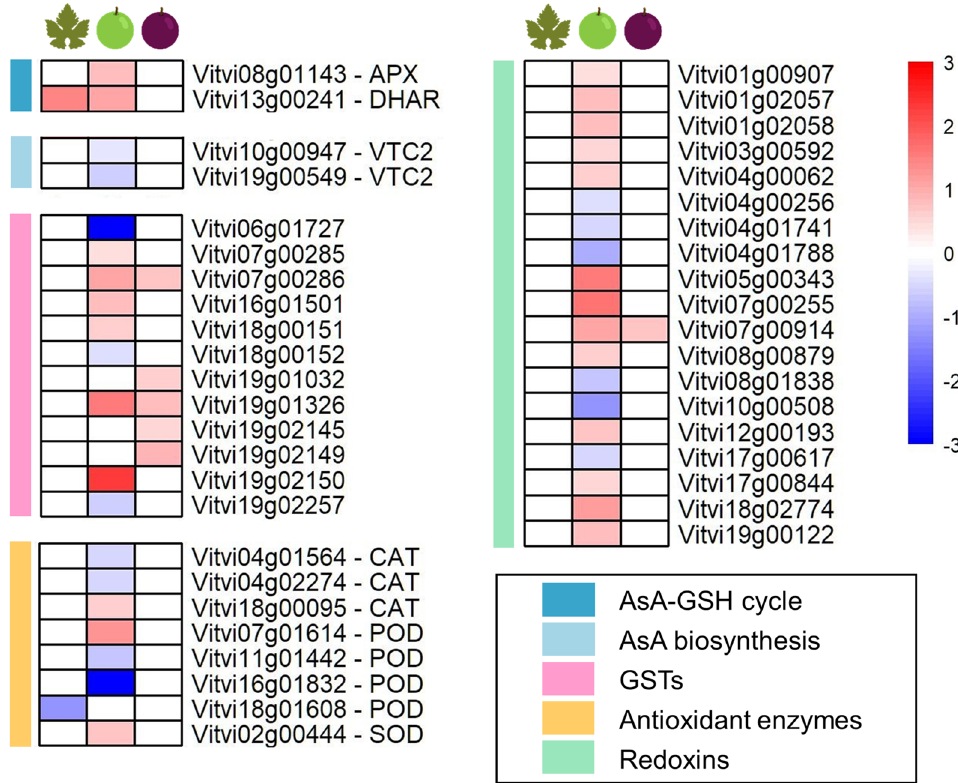
Figure 5. Oxidative stress-related genes modulated by the ozonated water treatment in leaves (left column), berries at the beginning of ripening (middle column) and berries in mid-ripening (right column) are represented in heatmaps as log 2 FC(OW/C). Red and blue colours indicate up- or down-regulation, respectively. The coloured sidebar on the left displays the class of